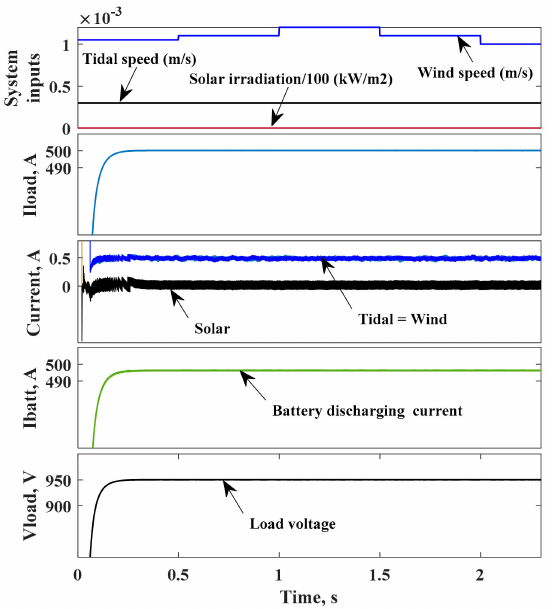
Figure 18. Case-c: performance of a single floating energy unit at load shedding condition when RES supply zero energy.